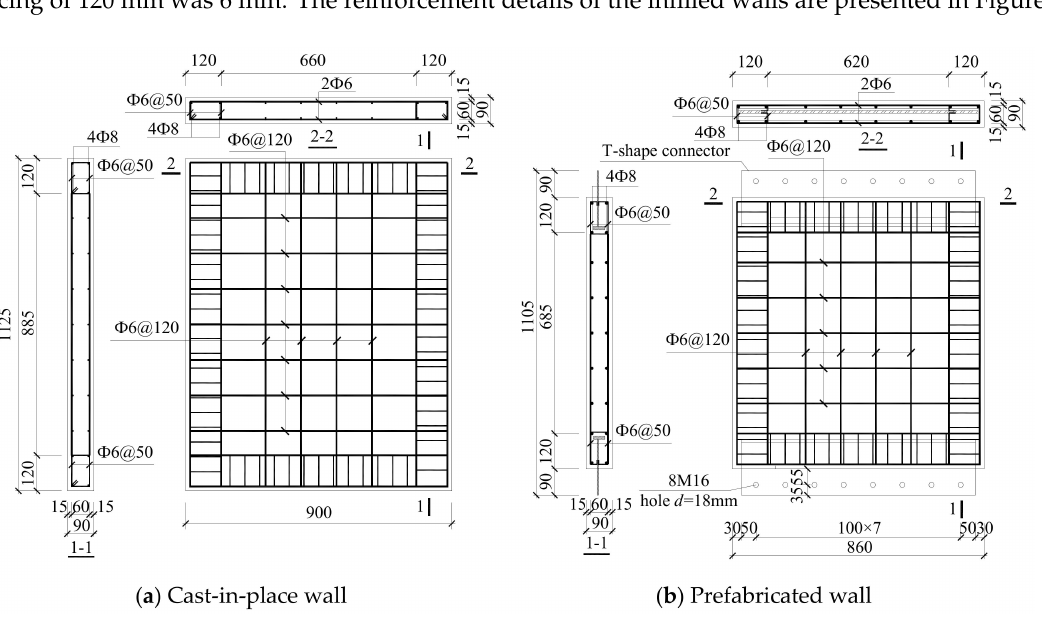
Figure 2. Reinforcement details of infilled